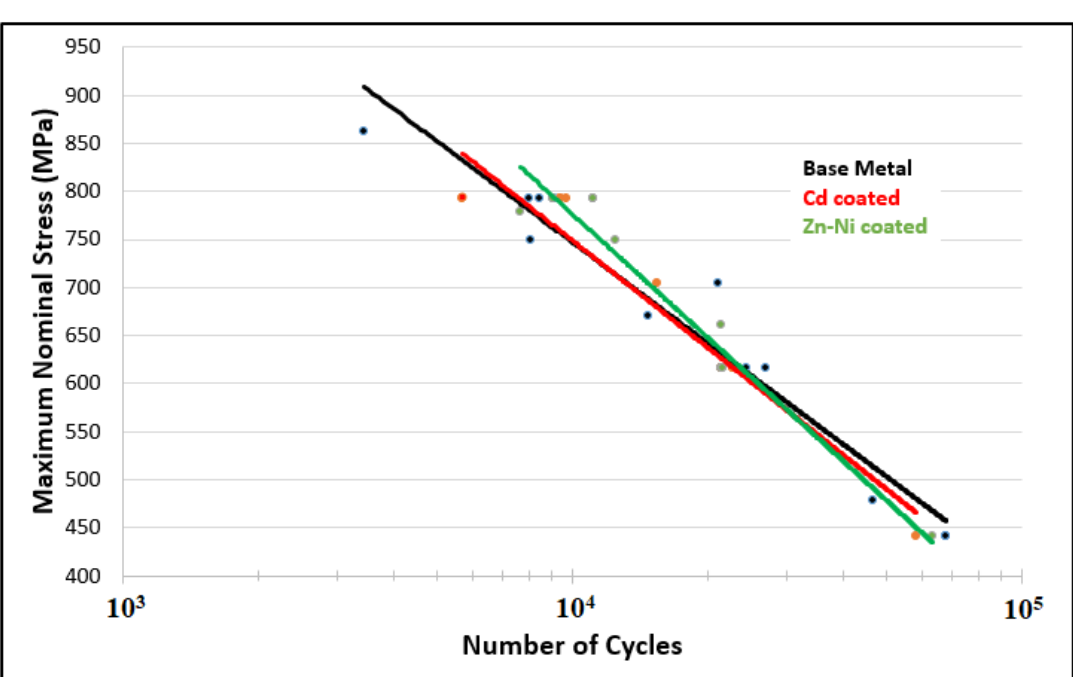
Figure 8. Fatigue life, threaded